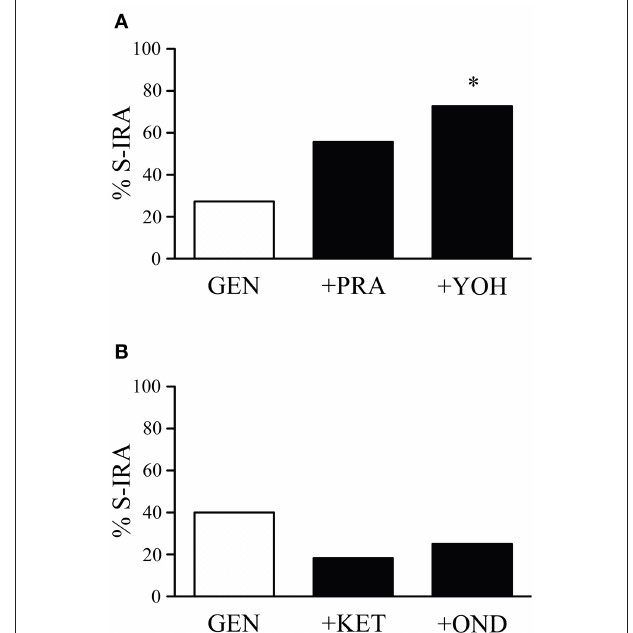
FIGURE 2 | The suppressing effect of genistein on S-IRA in DBA/1 mice is prevented by an α 2 adrenoceptor antagonist but not by an α 1 adrenoceptor antagonist as well as a 5-HT 2A or 5-HT 3 receptor antagonist. (A) Compared with the incidence of S-IRA evoked by genistein alone (1 mg/kg), administration of the α 2 adrenoceptor antagonist yohimbine (5 mg/kg) 30min prior to genistein injection (1 mg/kg) significantly elevated S-IRA incidence. Administration of the α 1 adrenoceptor antagonist prazosin (1 mg/kg) 30min before genistein injection (1 mg/kg) did not significantly change S-IRA incidence compared with that evoked by genistein alone (1 mg/kg). (B) Compared with the incidence of S-IRA evoked by genistein alone (1 mg/kg), administration of the 5-HT 2A receptor antagonist ketanserin (0.5 mg/kg) or the 5-HT 3 receptor antagonist ondansetron (2 mg/kg) 30min prior to genistein injection (1 mg/kg) did not significantly alter S-IRA incidence. * p < 0.05: Significantly different from the effect on S-IRA evoked by genistein